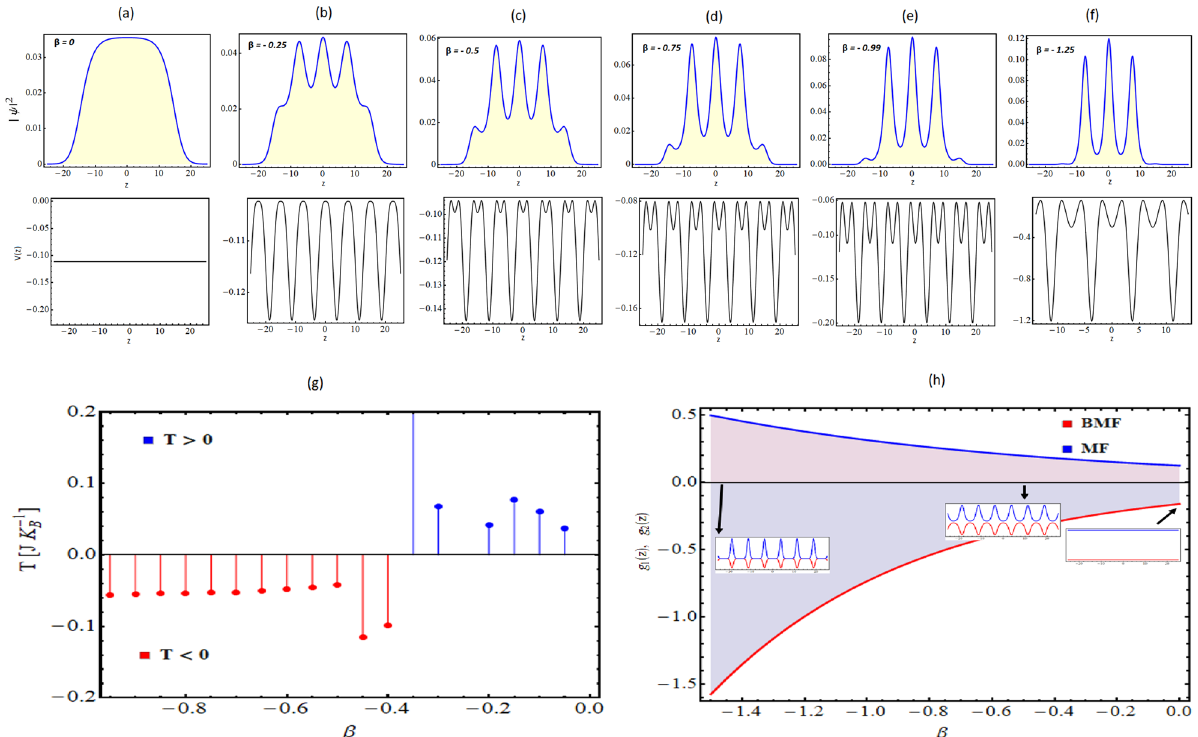
0 and β 0 : ( a ) β 0 (free Figure 2. Condensate density patterns and corresponding BOL trap with M = = = 0.25 , ( c ) β 0.5 , ( d ) β 0.750 , ( e ) β 0.99 , and ( f ) β 1.25 . Each plot of ( a – f ) has space); ( b ) β = − = − = − = − = − two panels: the upper panel shows the density plot, and the lower panel indicates the corresponding trap profile. 1 ( g ) The figure depicts the estimate of temperature ( JK − B ) with respect to the potential depth of BOL ( β ) and illustrates positive to negative temperature transition. ( h ) The profile of EMF and BMF is plotted by changing β 0.84 , G 1 1 , G 2 0.999999 , E 0 . Here, the magnitude of physical parameters: γ 0 1 , k 2 / 9 . for z = = − = = = = − The spatial coordinate is scaled by the oscillator length. Figures are plotted using MATLAB R2020b